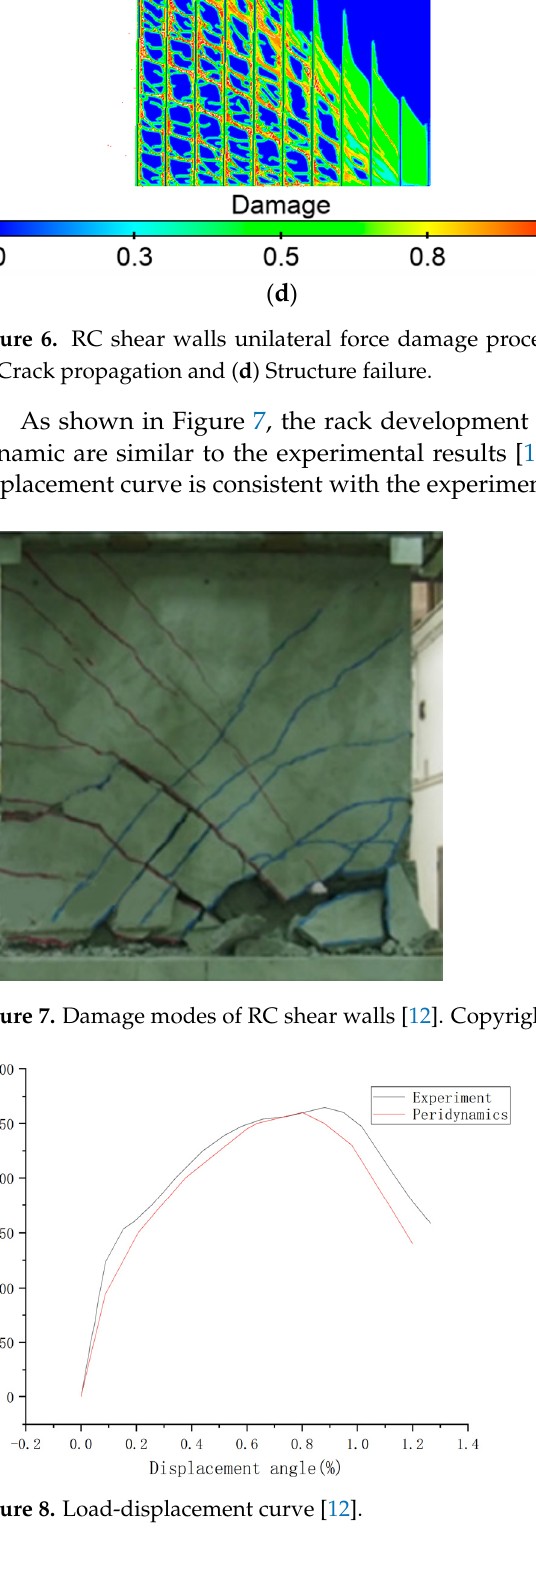
Figure 8. Load-displacement curve [12].